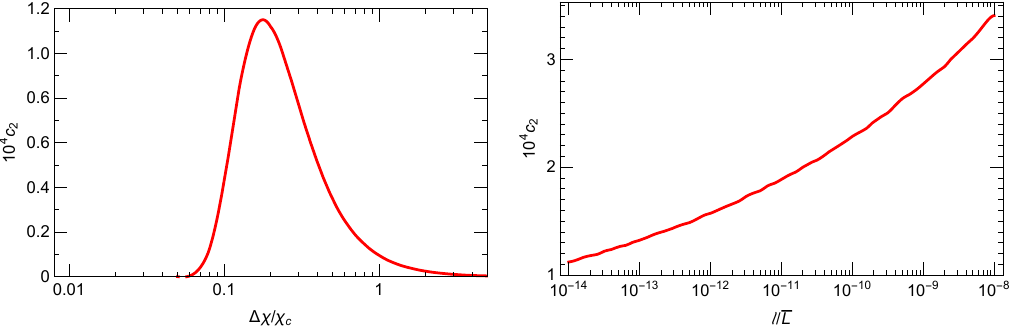
Figure 7 . Left: c 2 as a function of ∆ χ /χ c , fixing ‘/L = 10 − 14 . Right: c 2 as a function of ‘/L , fixing ∆ χ /χ c = 0 . 2 .